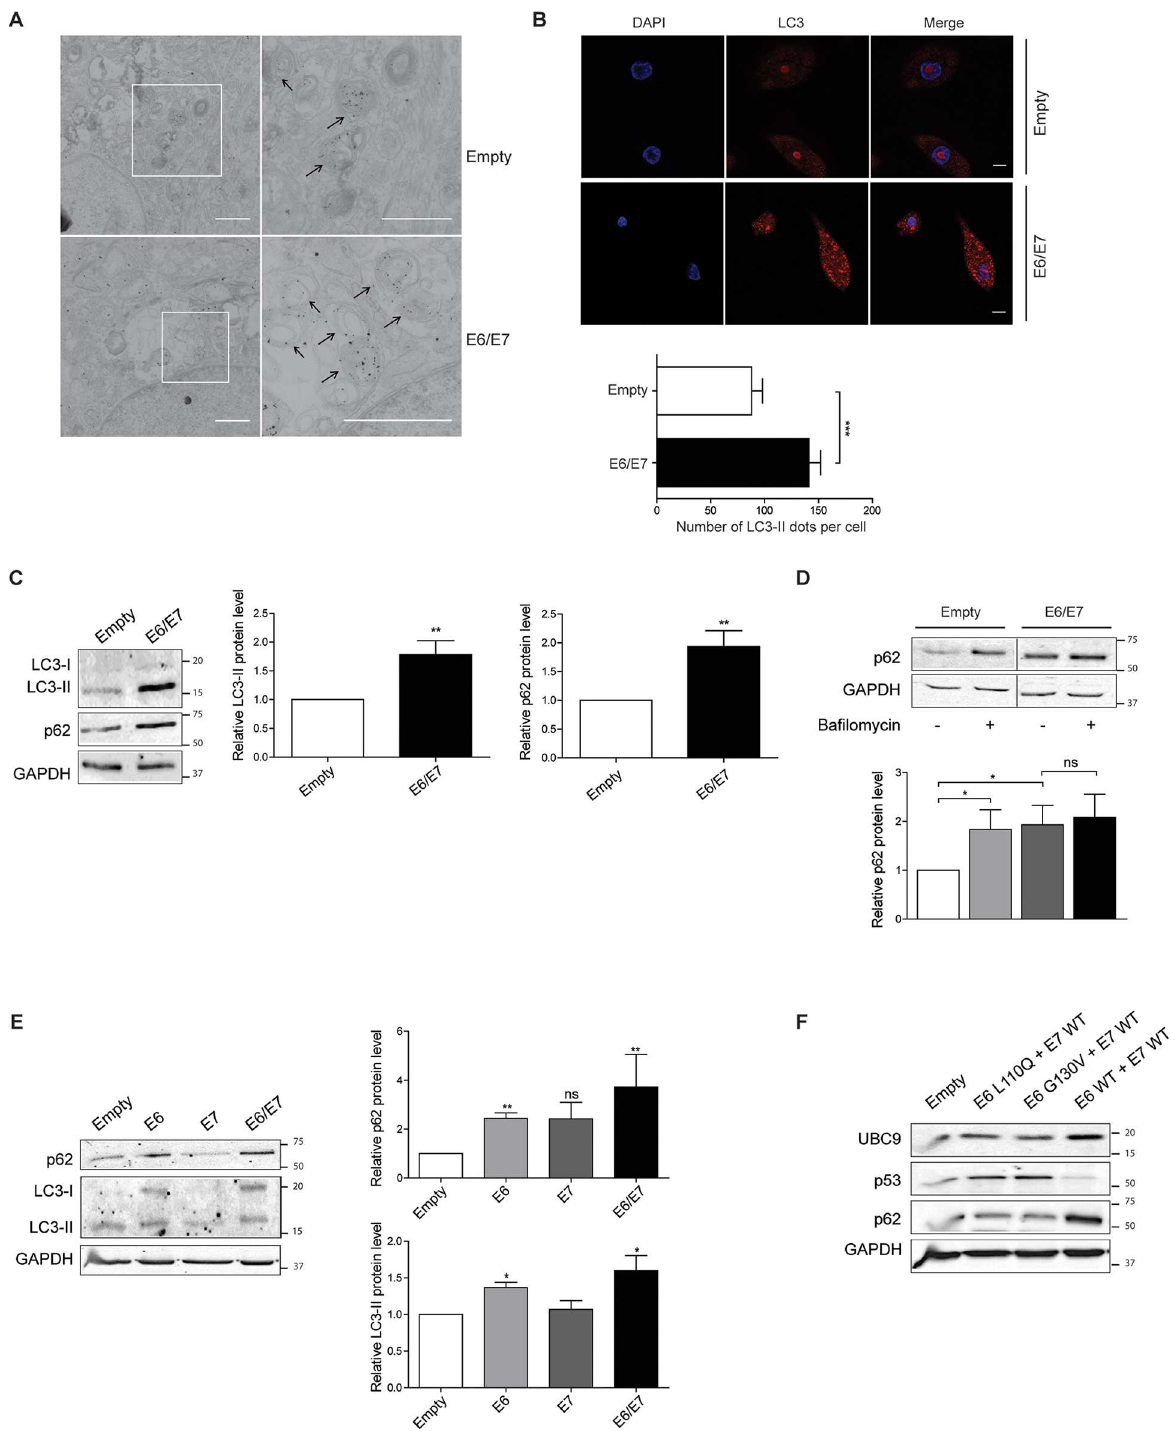
Fig 8. HPV16 E6/E7 inhibit late autophagy. (A) Immunolocalizationof LC3 in ultrathin sections of HKs transduced with empty or HPV16E6/E7 vectors. Originalview (left) and highermagnification (right)of boxedregions.Nanogoldparticlesare selectively enrichedin autophagic structureshighlightedby arrows. Scalebar = 1 μ m. (B) Top: Confocalmicroscopy imagesof empty or HPV16 E6/E7 transduced HKs immunostainedwith antibody againstLC3 (red). Nucleiwerestainedwith DAPI (blue).Scalebar = 5 μ m. Bottom: Quantificationof endogenous LC3 dot total area. Data are expressedas numberof LC3dots. Bars representmeans ± SEM of n = 50 fields of three different biologicalreplicates. *** P < 0.0001(independent-samplet test). (C) Left: Representative WB analysisof LC3 and